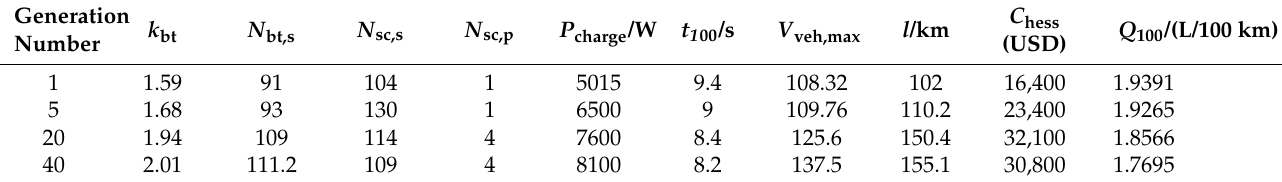
Table 8. Simulation results.